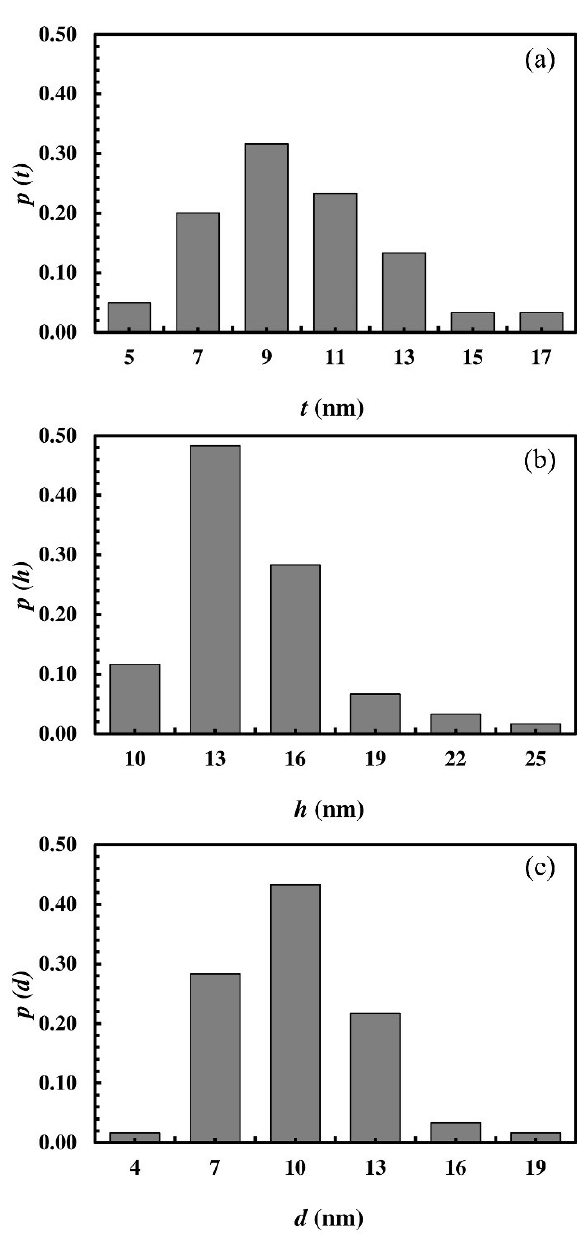
Figure 10. Statistical distributions of ( a ) effective ligament length h ; ( b ) ligament thickness t ; and ( c ) characteristic length of nodes d . These distributions are obtained from image analysis applied to previous work by Volkert et al.